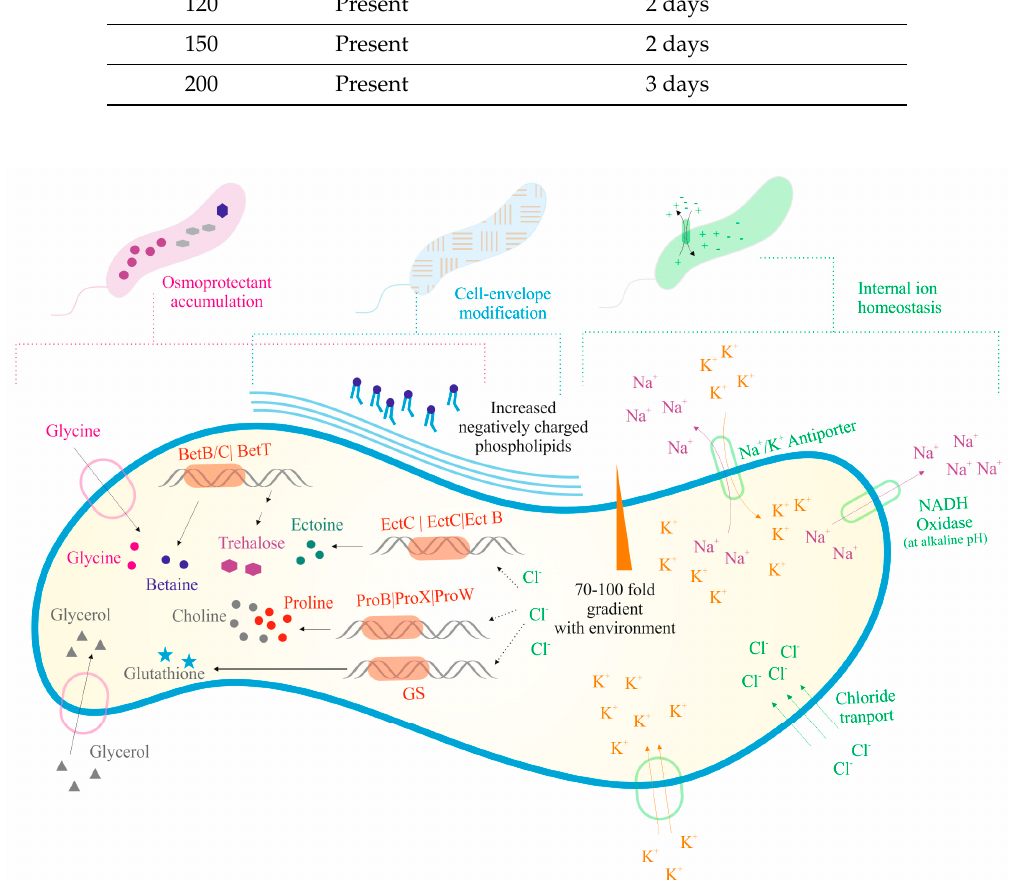
Figure 3. A schematic representation of salt tolerance mechanisms in Salinivibrio sp. HTSP based on genome analysis. Genes involved in osmoprotectant accumulation and biosynthesis such as ectoine, choline, betaine, glycerol, etc. are found in the cell. Various ion transporters such as the potassium transporter, Na + / H + antiporter, and Cl transporters were detected for maintaining the internal ion